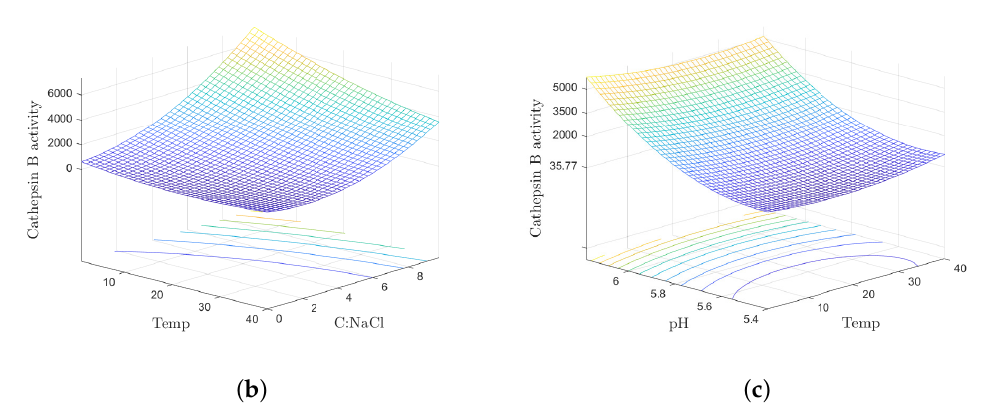
Figure 1. The formation of flavor substances in Jinhua ham and the interactive effect between processing parameters. ( a ) Formation of flavor substances in Jinhua ham and the role of endoge- nous protease [18]. ( b ) Effects of temperature and pH value on cathepsin B activity. ( c ) Effects of temperature and salt content on cathepsin B activity